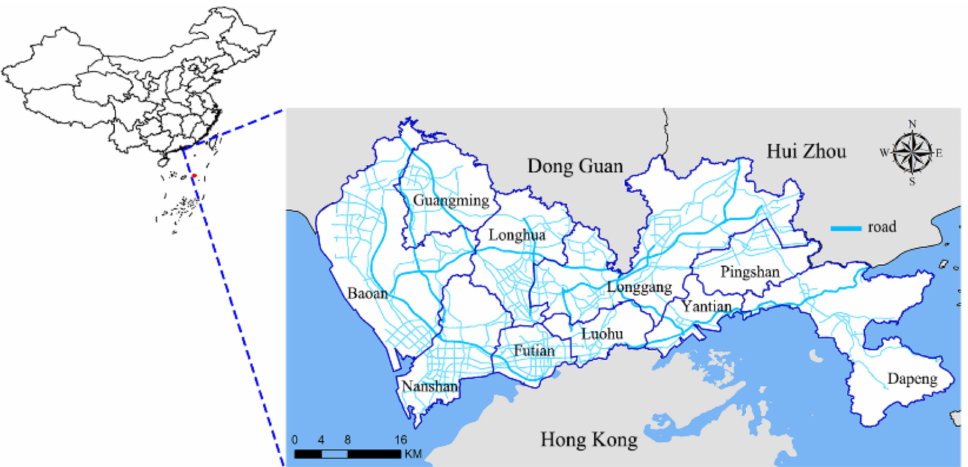
Figure 1. The study area in